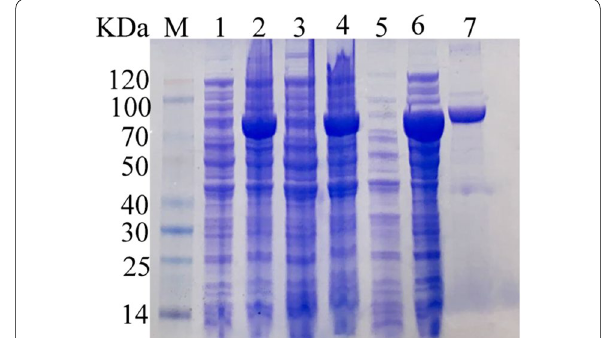
Fig. 3 SDS–PAGE analysis of the target protein Amy2587. M: Protein marker; Lane 1: Whole-cell of recombinant Escherichia coli BL21 (DE3) cells harboring pET-30(a)- amy2587 before induction; Lane 2: Whole-cell of recombinant Escherichia coli BL21 (DE3) cells harboring pET-30(a)- amy2587 after induction; Lane 3: Supernatant of recombinant Escherichia coli BL21 (DE3) cells harboring pET-30(a)- amy2587 before induction; Lane 4: Supernatant of recombinant Escherichia coli BL21 (DE3) cells harboring pET-30(a)- amy2587 after induction; Lane 5: Precipitate of recombinant Escherichia coli BL21 (DE3) cells harboring pET-30(a)- amy2587 before induction; Lane 6: Precipitate of recombinant Escherichia coli BL21 (DE3) cells harboring pET-30(a)-amy2587 after induction; Lane 7: Purified Amy2587